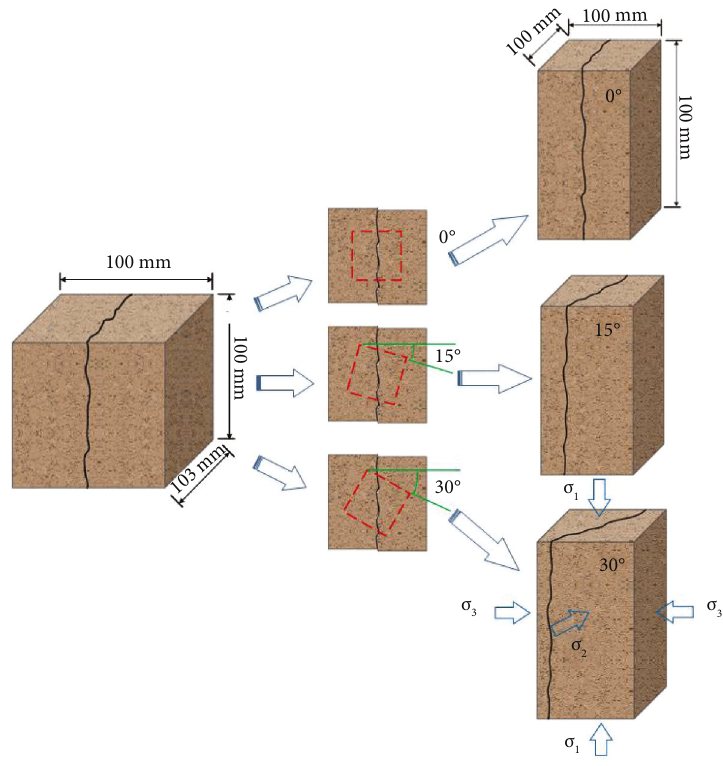
Figure 5: The manufacturing process of single-fracture specimens with di ff erent inclination angles.